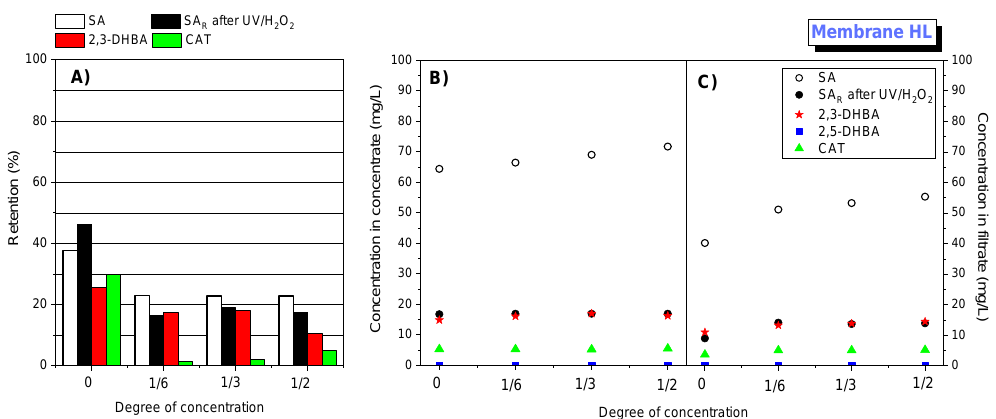
Figure 4 . ( A ) Dependence of retention on the degree of initial bath concentration; ( B ) dependence of concentration of salicylic acid and products of its oxidation in the concentrate on the degree of initial bath concentration; ( C ) dependence of concentration of salicylic acid and products of its oxidation in the filtrate on the degree of initial bath concentration; HL membrane, pressure 1.0 MPa, temperature 30 °C. Abbreviations: SA- salicylic acid; 2,3-DHBA- 2,3-dihydroxybenzoic acid; 2,5-DHBA- 2,5-dihydroxybenzoic acid; CAT- catechol; SA R -residual salicylic acid after UV/H 2 O 2 .